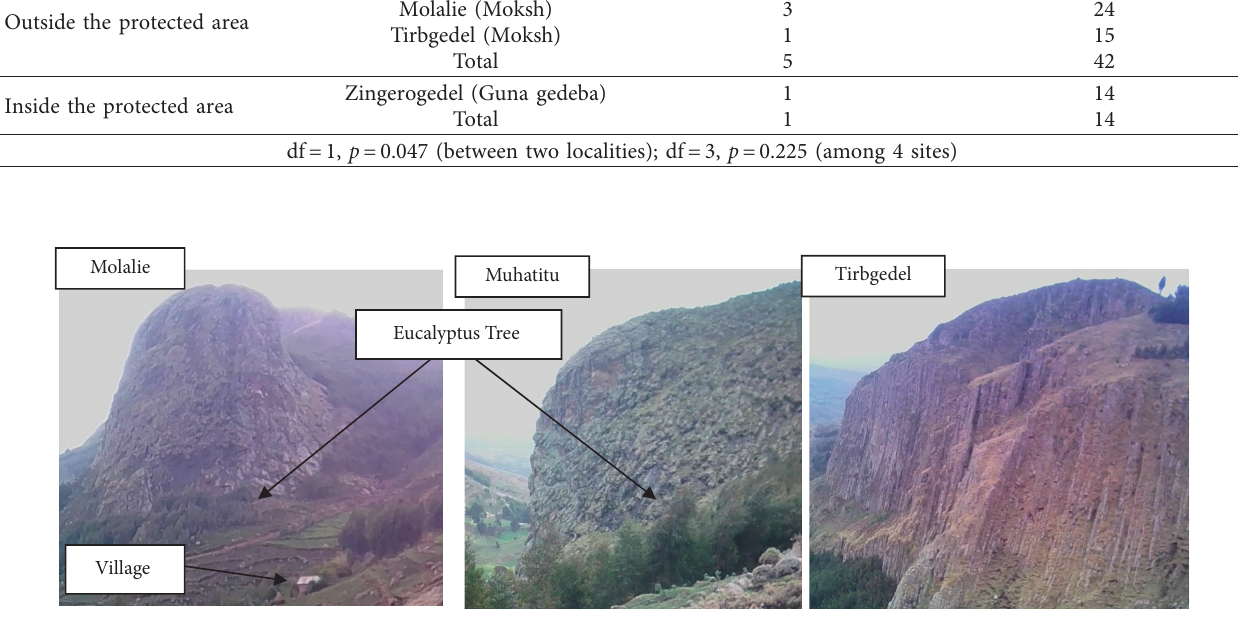
Figure 3: Gelada habitats outside the protected area (photos captured by data